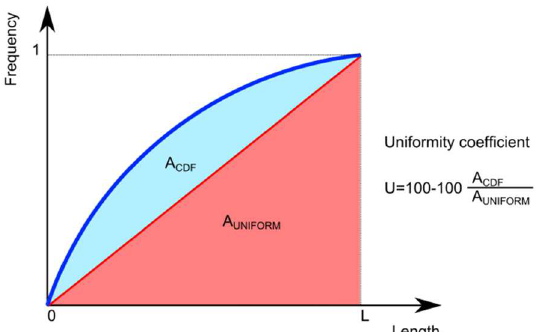
Fig. 6. CDF of the uniform layer (in red) and the real fouling layer (in blue).